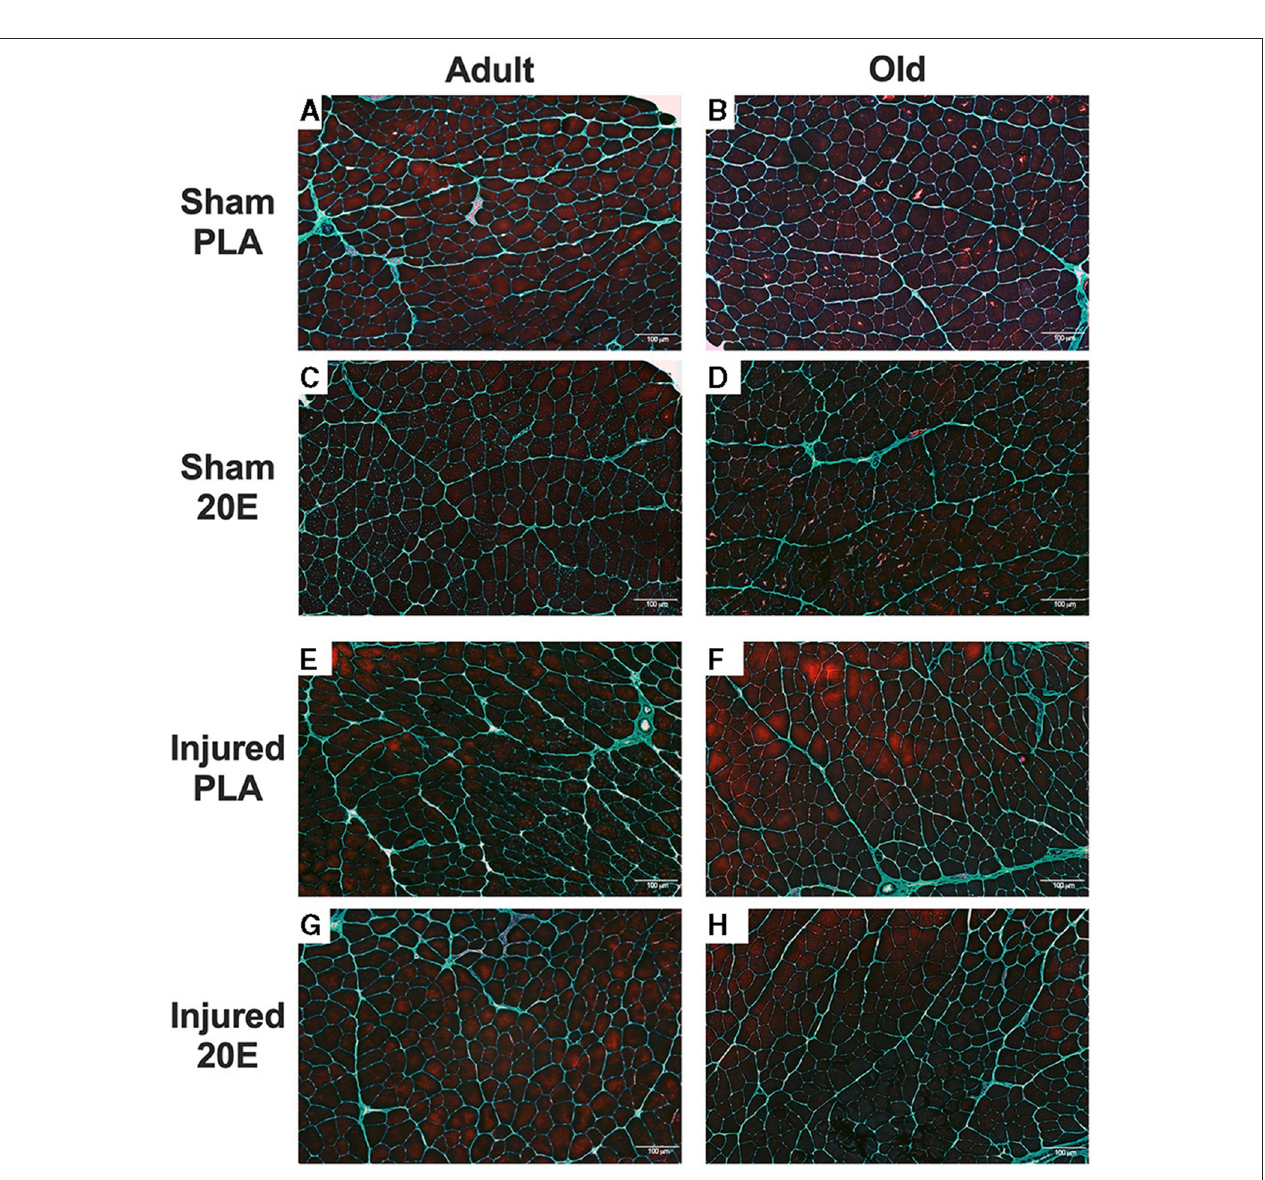
FIGURE 4 | of muscle damage were assessed in eccentric contraction-injured TA muscle sections to obtain a Muscle Damage Score based on a scale of 0–3, with 0 = no apparent muscle damage; 1 = minimal muscle damage; 2 = moderate muscle damage; and 3 = severe muscle damage. Muscle damage scores appear to be higher in the PLA-treated groups, compared to 20E-treated groups, but the old PLA-treated mice appear to have the greatest muscle damage score at 7 days post-injury, compared to any other group. Values represent mean ± SEM. PLA, placebo; 20E, 20-hydroxyecdysone. Scale bar = 100 µ m.